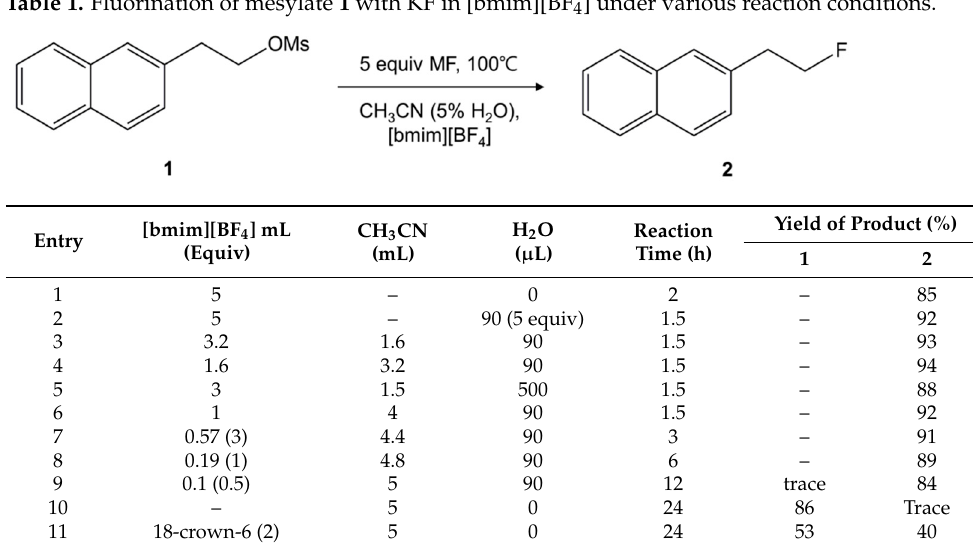
Scheme 2. Fluorination of mesylates with KF or CsF in ionic liquids. Table 1. Fluorination of mesylate 1 with KF in [bmim][BF 4 ] under various reaction conditions.